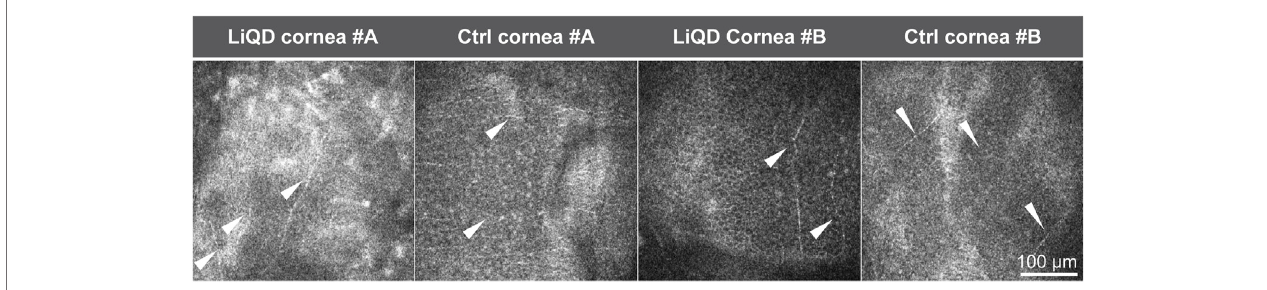
FIGURE 6 | Ex Vivo confocal microscopy. Restitution of a sub-basal plexus with numerous parallel bundles of regenerated nerves (arrowheads) similar to those found in the unoperated